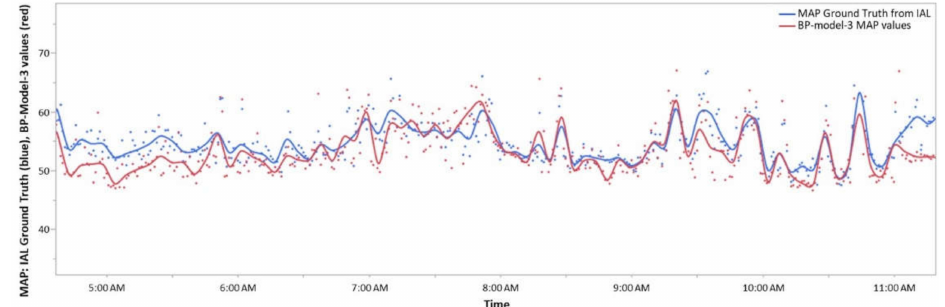
Figure 8. Comparison of invasive arterial line (blue) and BP-model-3 (red) mean arterial pressure (MAP) values as a function of time. Each data point is averaged over a one-minute interval. The curves are a spline fit with lambda = 1 × 10 − 6